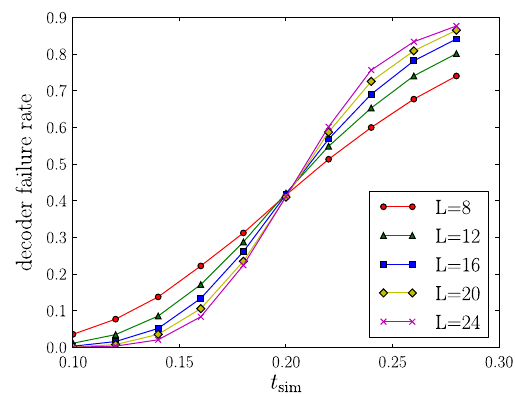
FIG. 6. Failure probability versus simulation time (average errors per edge) for γ ψ c ¼ γ σ c using the PMA decoder on the Ising topological